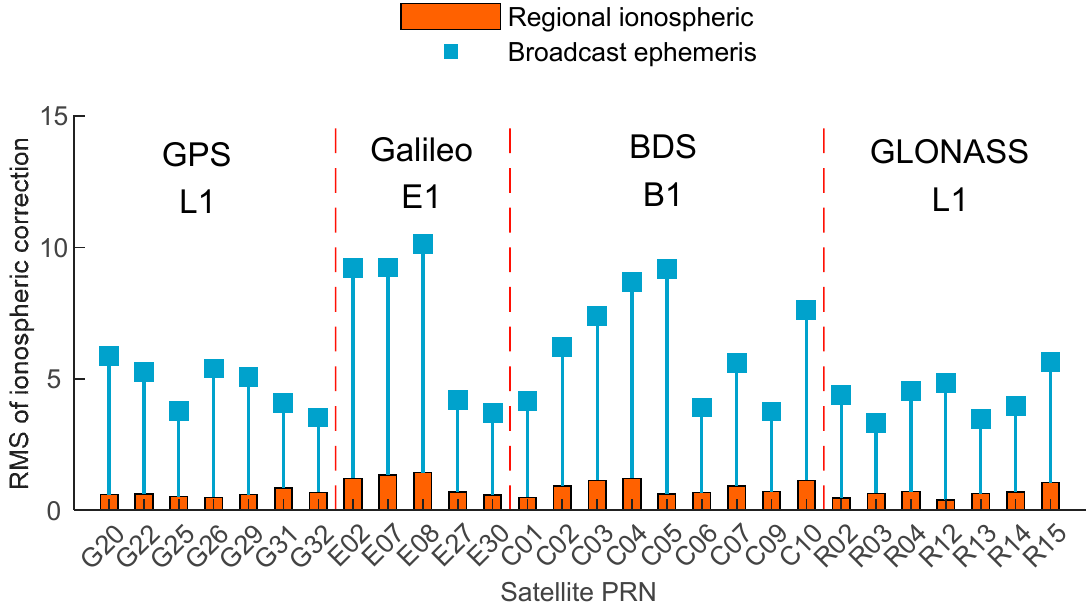
Figure 7. The RMS of ionospheric delay correction of the Klobuchar and the regional ionospheric model.